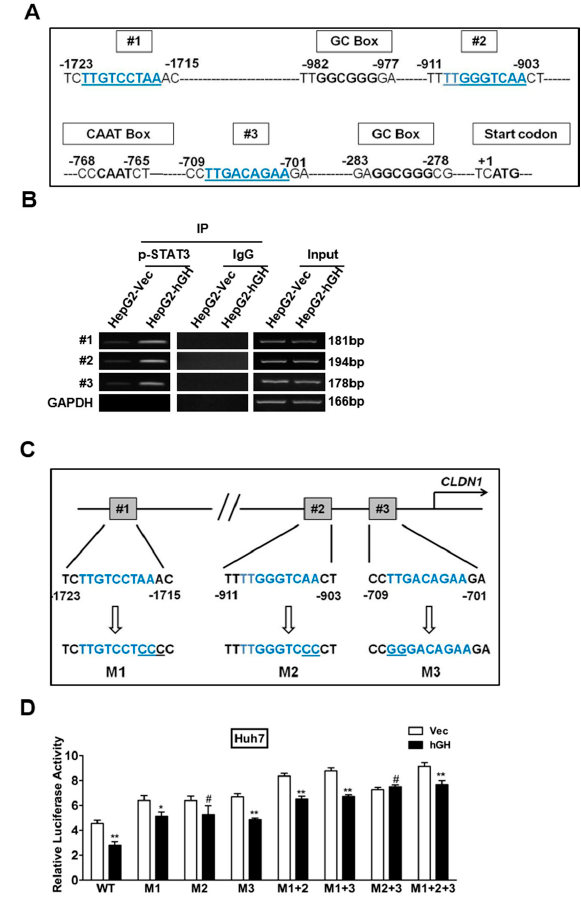
Figure 4. Identification of the STAT3-targeted region within the human CLAUDIN-1 promoter. ( A ) Schematic illustration of the proximal region of the human CLAUDIN-1 promoter. The human CLAUDIN-1 promoter contains three putative STAT3-binding sites shown as underlined blue letters (designated #1, #2 and #3). Two GC boxes were also identified in the proximal region of the human CLAUDIN-1 promoter as shown; ( B ) hGH enhanced direct binding of STAT3 to the three STAT3-binding sites in the CLAUDIN-1 promoter region, as revealed by chromatin immunoprecipitation (ChIP) analysis. HepG2-Vec/hGH cells were subjected to ChIP analysis using an anti-pSTAT3 antibody or a normal rabbit immunoglobulin G (IgG). DNA precipitates were PCR amplified using three pairs of primers, amplifying the three STAT3-binding sites, respectively; or primers for glyceraldehyde 3-phosphate dehydrogenase (GAPDH), used as an input control; ( C ) Mutations (M1, M2, M3) were introduced in the STAT3-binding sites in the proximal region of human CLAUDIN-1 promoter. The top panel shows the wildtype (WT) sequence of STAT3 binding sites within the CLAUDIN-1 promoter, while the bottom panel shows the mutated sequence of the STAT3 binding sites with the mutation sites being underlined; ( D ) Activity of the WT and 7 mutant luciferase reporter constructs (designated M1, M2, M3, M1 + 2, M1 + 3, M2 + 3, and M1 + 2 + 3). Huh7-Vec/hGH cells were transfected with the WT or mutant constructs, and Renilla plasmids. After 48 h, the luciferase activity was determined by normalizing against the Renilla luciferase activity. The statistical significance was determined by comparing the luciferase activity in Huh7-hGH cells to that in Huh7-Vec cells. * p < 0.05; ** p < 0.01, # no statistical